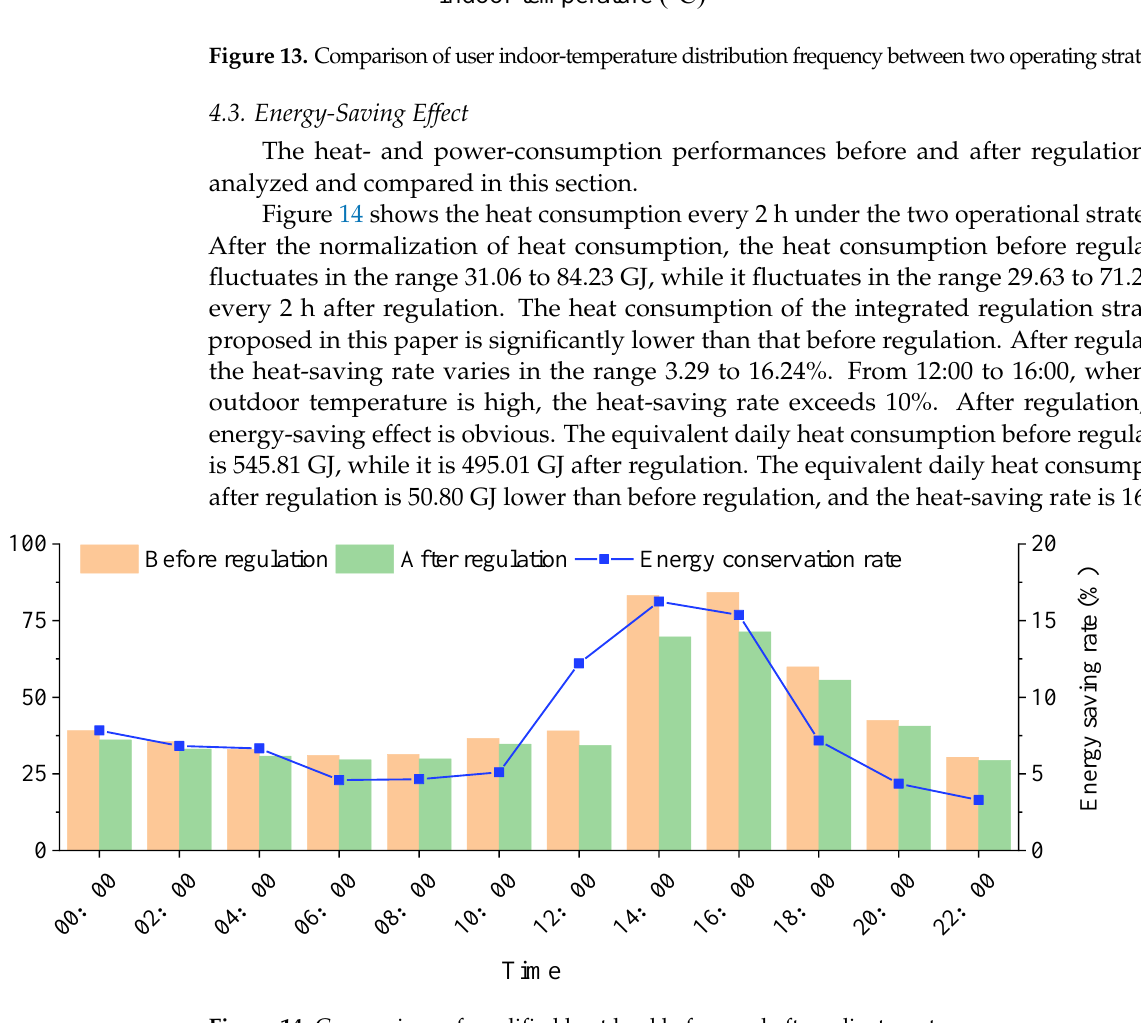
Figure 14. Comparison of modified heat load before and after adjustment.